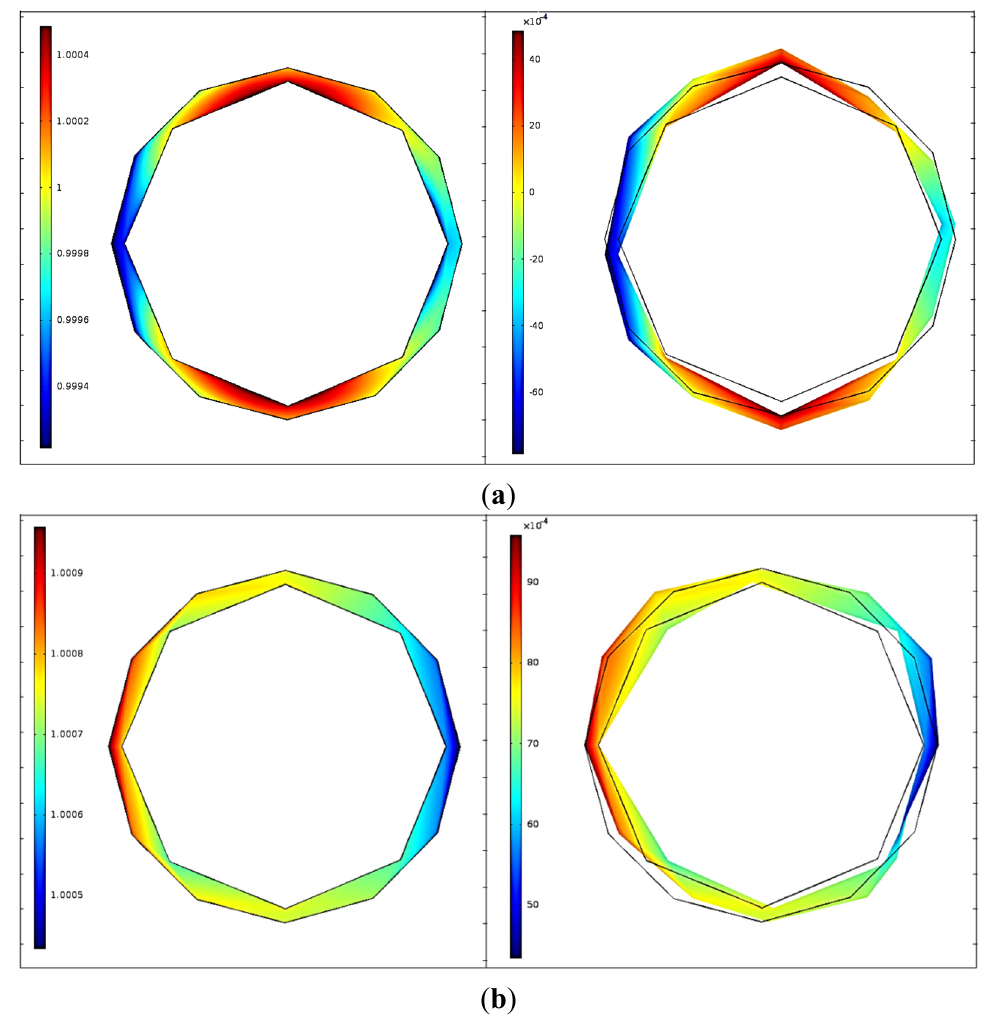
Figure 24. Maximum principal stretches (undeformed, on the left) and strains (deformed, on the right): ( a ) vertical direction and ( b ) horizontal